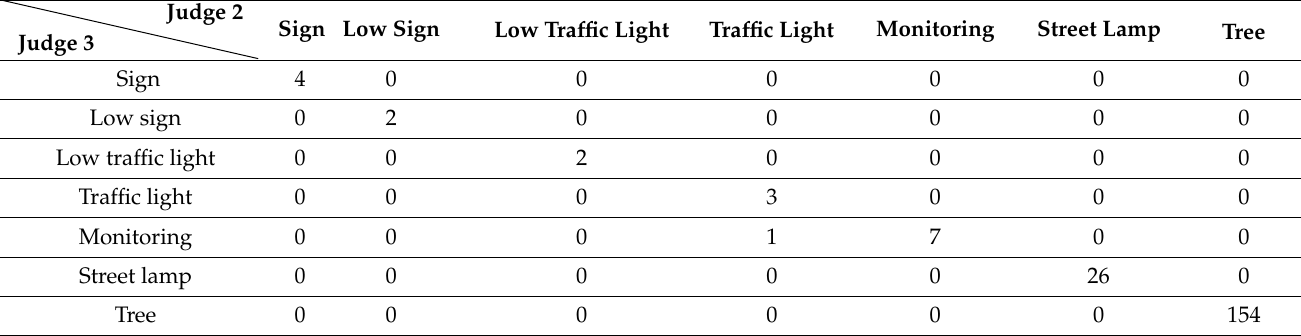
Table A3. This table show the result of Cohen’s kappa coefficient between judge two and judge